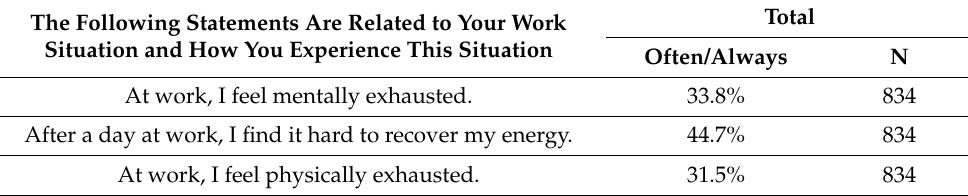
Table 3. Frequency of Polish school principals’ mental and physical exhaustion during the COVID-19